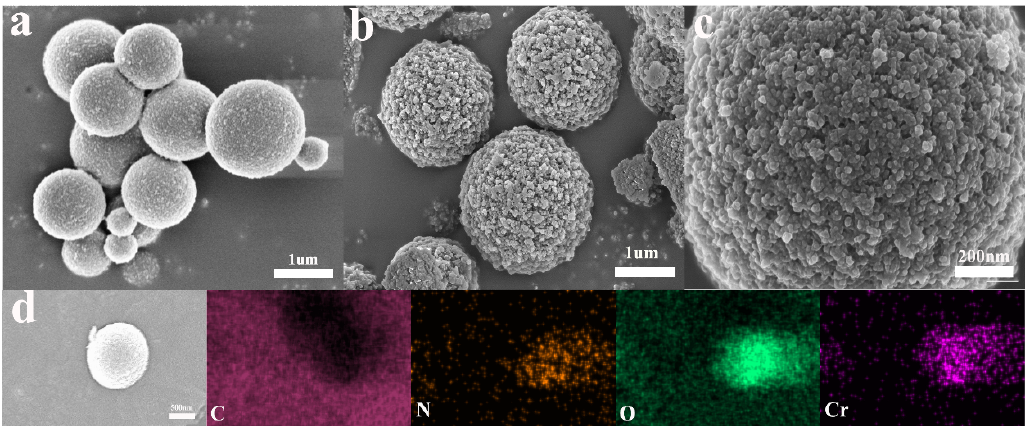
Figure 2. ( a ) SEM image of PTHA, ( b ) SEM image PEG@PTHA, ( c ) partial enlarged SEM image of PEG@PTHA, ( d ) EDS image of used PEG@PTHA.